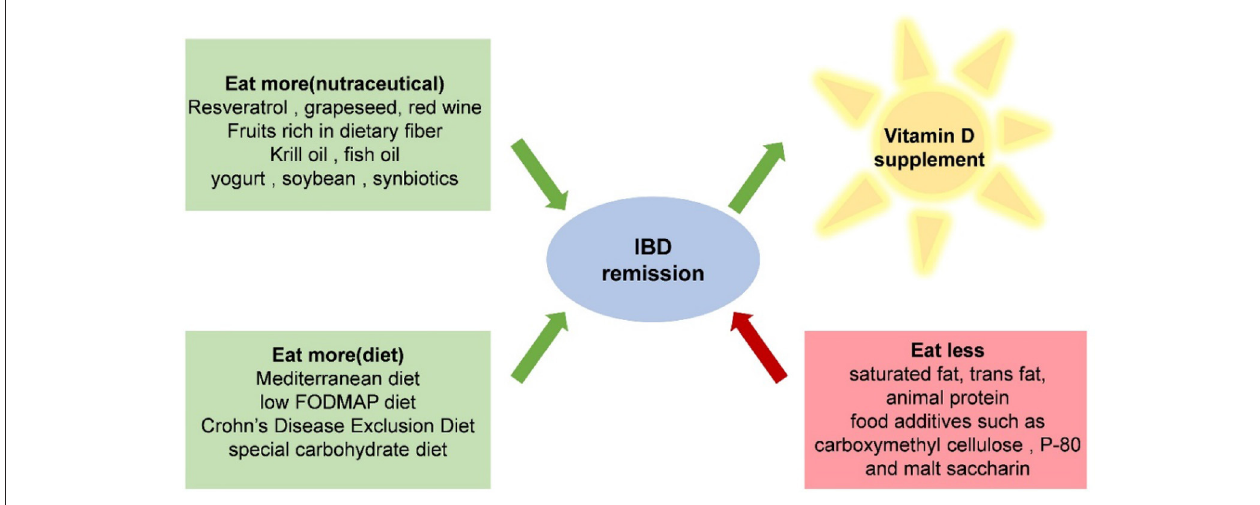
FIGURE 2 | Recommended dietary patterns, nutrients, and food ingredients that IBD patients should avoid.